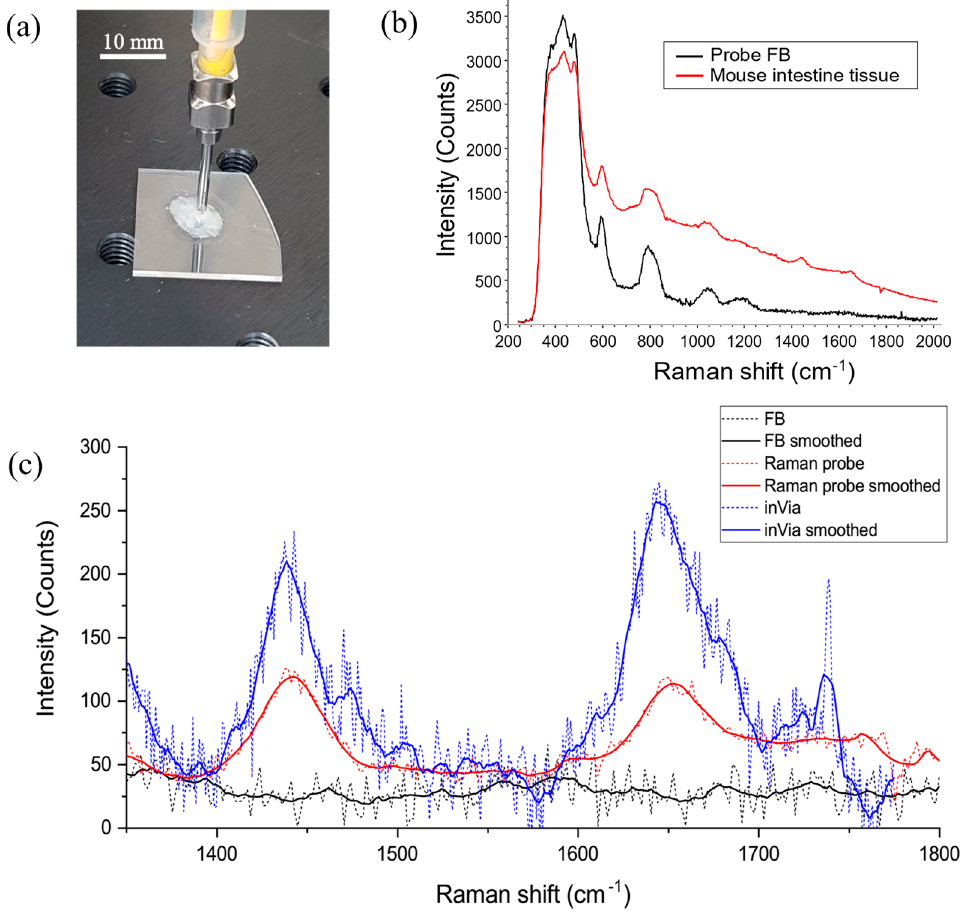
Figure 9. ( a ) A mouse intestine sample prepared on a fused silica substrate during spectral analysis with the Raman probe, embedded within the bore of a blunt needle, in light contact. ( b ) The average Raman spectra of eight tissue samples (red) and the FB (black) measured with the probe during 5 s acquisitions. ( c ) A portion of the spectrum between 1300 and 1800 cm − 1 highlighting relevant tissue Raman peaks measured with the Raman probe (red) and compared with the same measurement performed with a commercial inVia Raman microscope (blue).